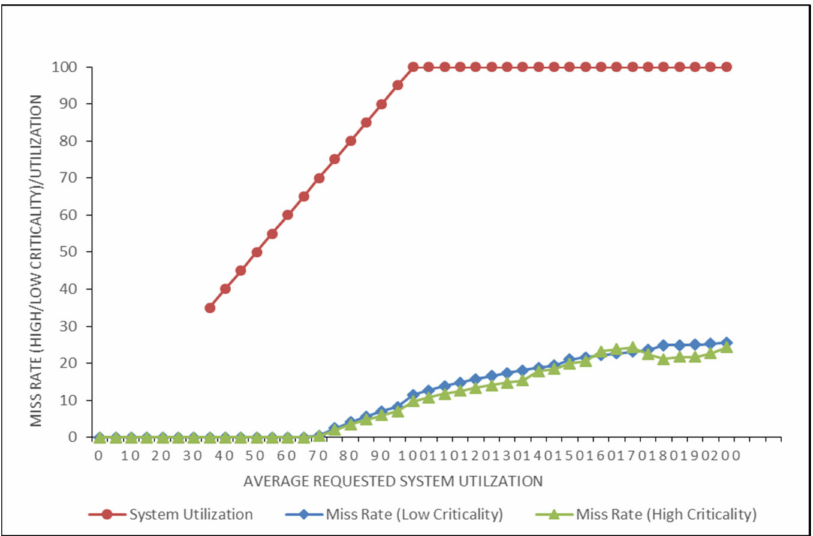
Figure 4. Static fixed priority